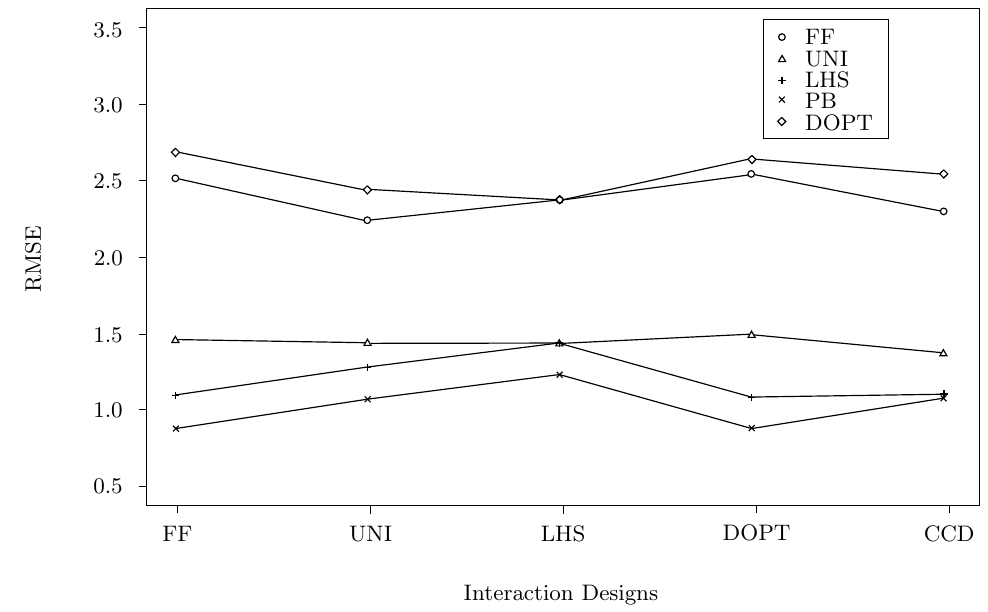
Figure 4: Plot of root mean square error (RMSE) values for the response surface model predictions (Screening designs: FF = Fractional Factorial Design, UNI = Uniform Design, LHS = Latin Hypercube Design, DOPT = D-Optimal Design, CCD = Central Composite Design, PB = Plackett-Burman